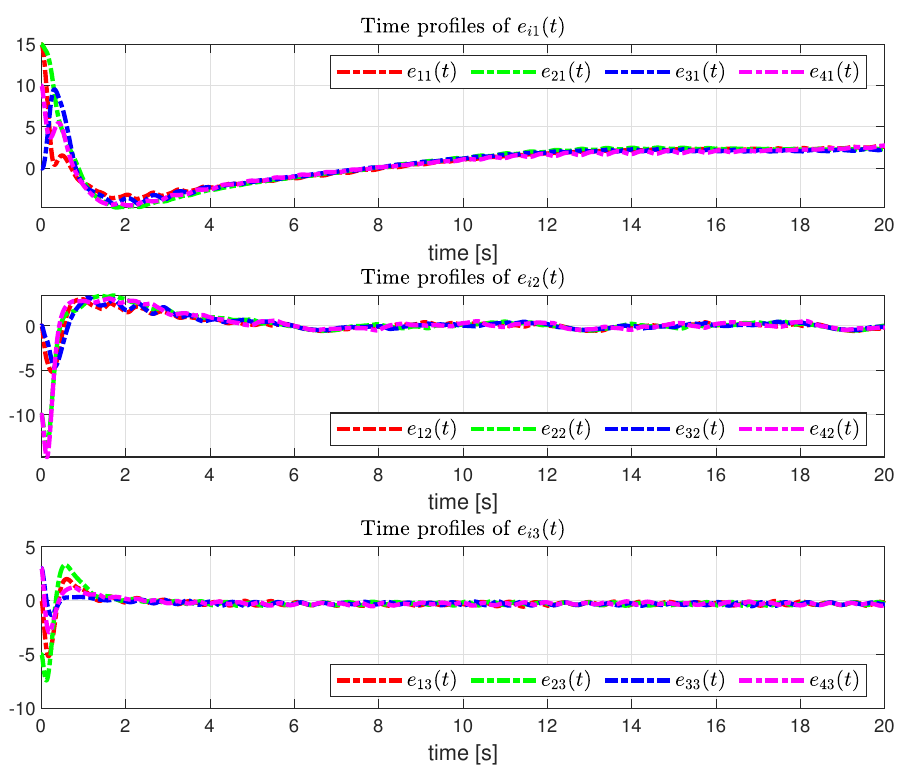
Figure 17. Performance of the robust internal model control law subject to relative position measure- ment noise with n P =